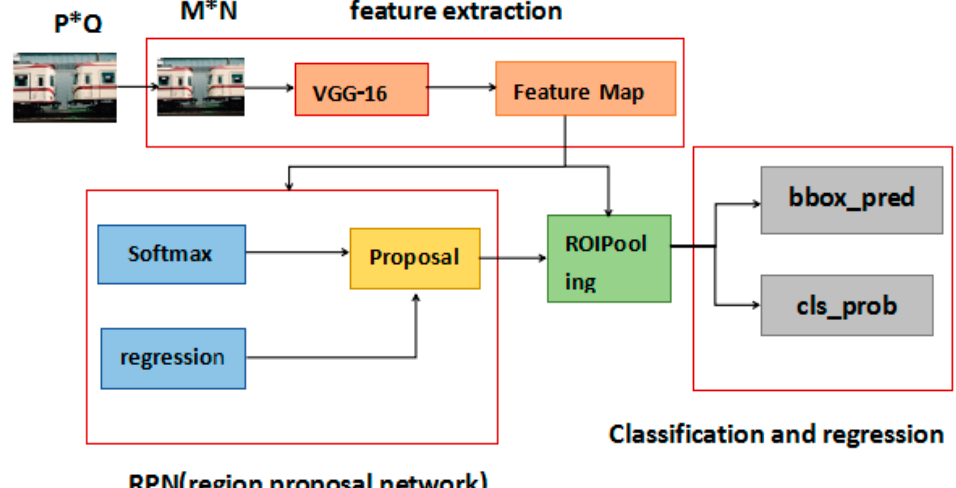
Figure 4. The architecture of Faster R-CNN. Faster R-CNN combines feature extraction net, region proposal net, and classification and regression into a network.